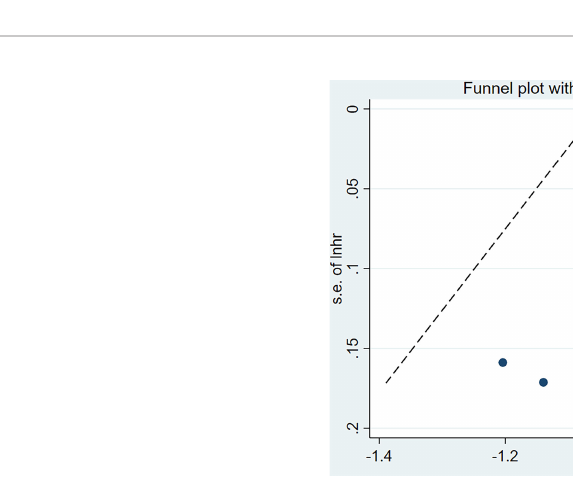
FIGURE 10 | The forest plot of the relative risk (RR) of grade 3-4 AEs of different PARPis as compared to the placebo. Each subplot represents a different AE. (A) Vomiting; (B) Thrombocytopenia; (C) Neutropenia; (D) Nausea; (E) Headache; (F) Fatigue or asthenia; (G) Dizziness; (H) Diarrhea; (I) Decreased appetite; (J) Cough; (K) Constipation; (L) Back pain; (M) Anemia; (N) Abdominal pain.